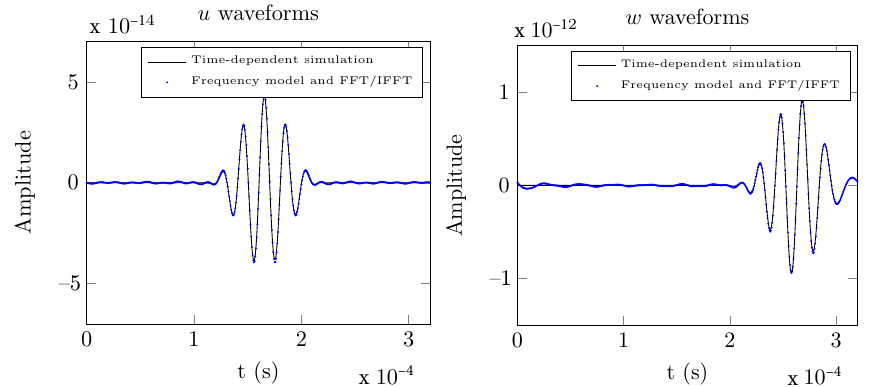
Figure 6. The u and w waveforms from time-dependent simulation and frequency-domain model with FFT/IFFT processing.